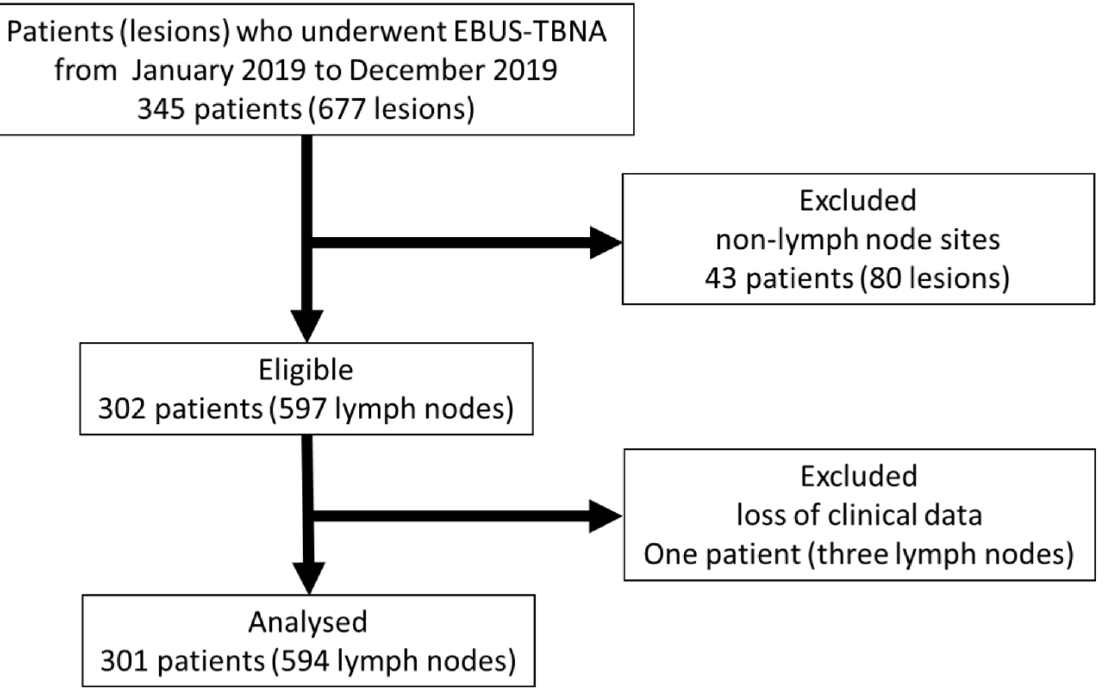
Figure 2. Flow chart of patient and lymph node recruitment. EBUS-TBNA, endobronchial ultrasound-guided transbronchial needle aspiration.